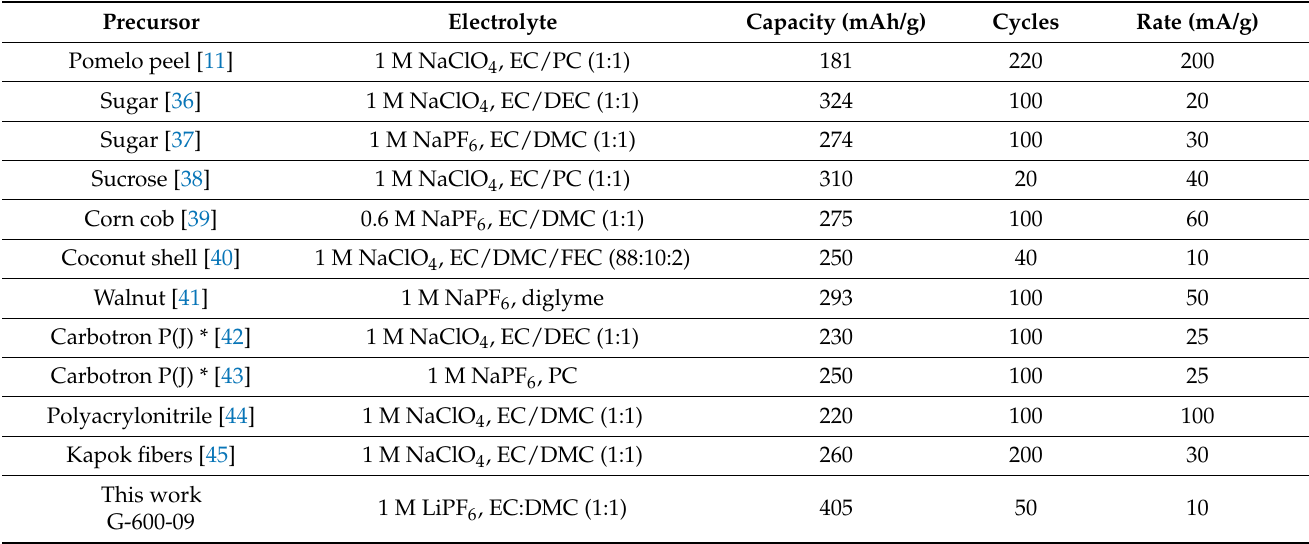
Table 3. Comparison of the electrochemical performance of hard carbons in literature.